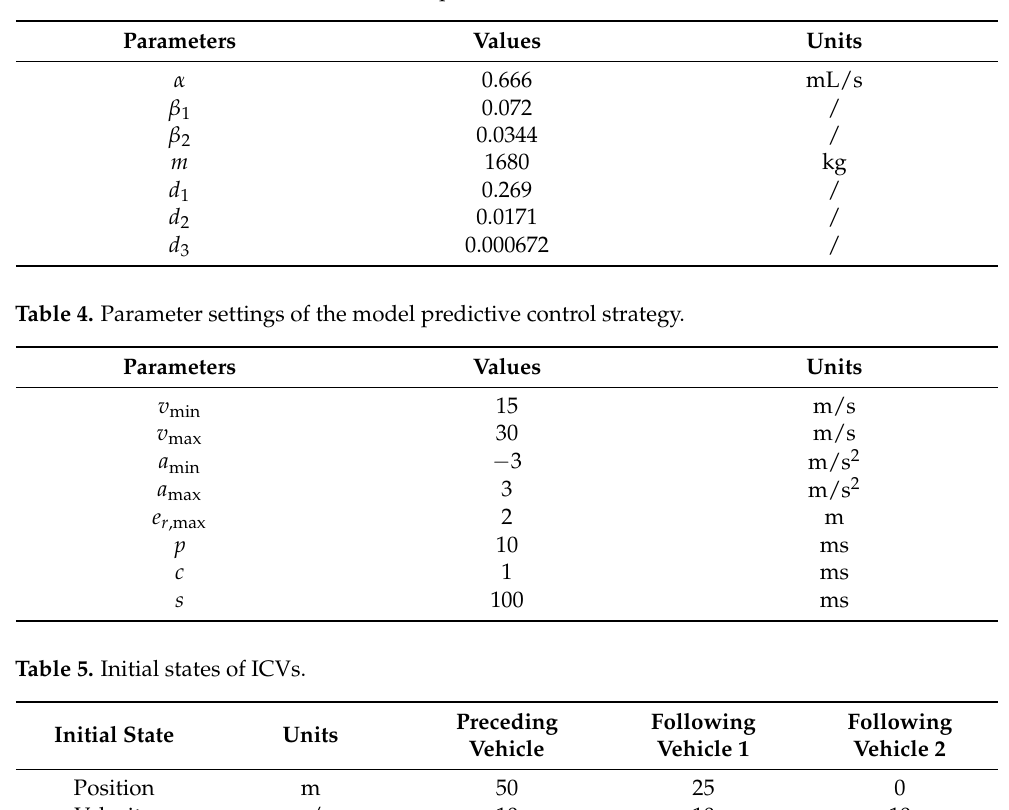
Table 3. Parameters related to fuel consumption.